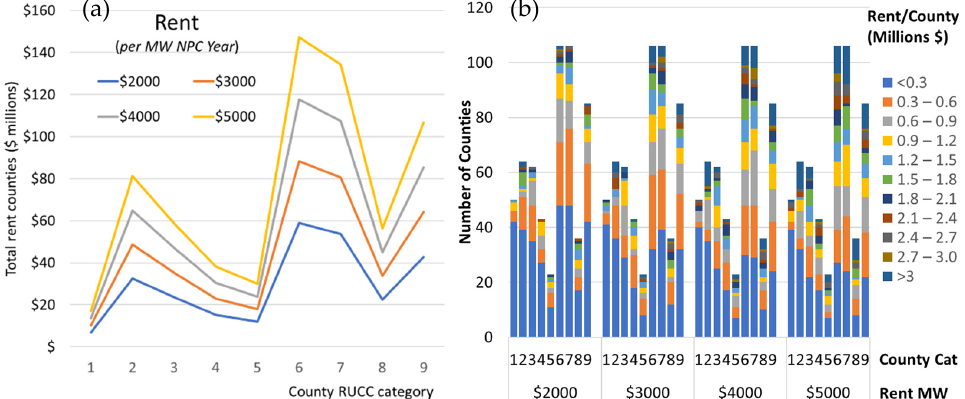
Figure 10. Rent payments from wind turbines classified according to location type from the USDA Rural–Urban Continuum Codes. ( a ) Yearly total rent payments per location type. ( b ) Number of counties classified by ranges of yearly total rent classified and location type.